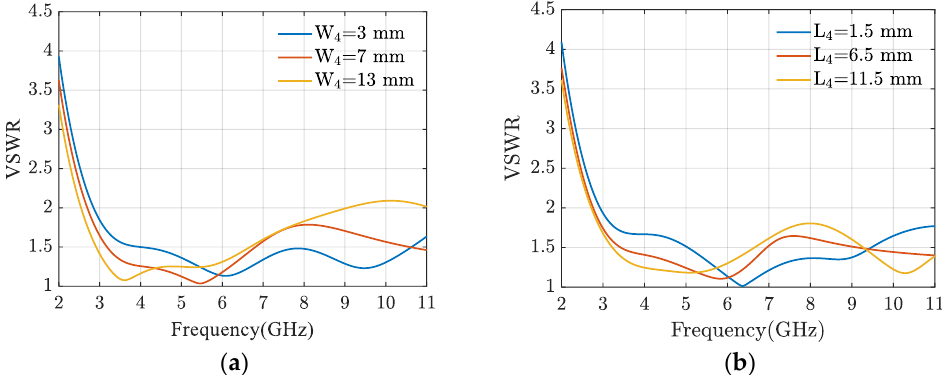
Figure 2. Simulated VSWR of the proposed antenna under different values of corner cut ( a ) W 4 ( b ) L 4 .